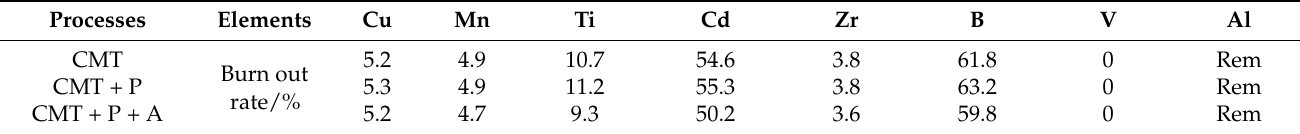
Table 3. Burning loss of the elements under the three deposition processes